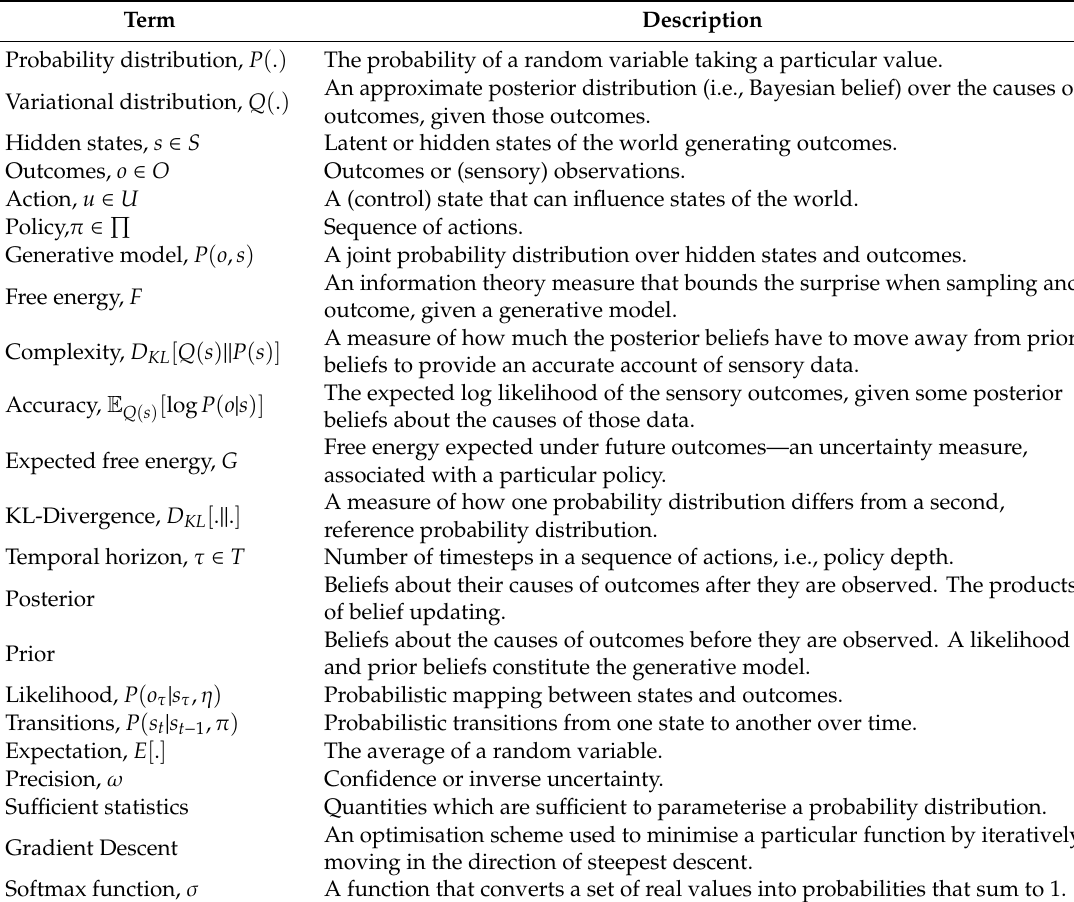
Table 1. Generic terms used in active inference